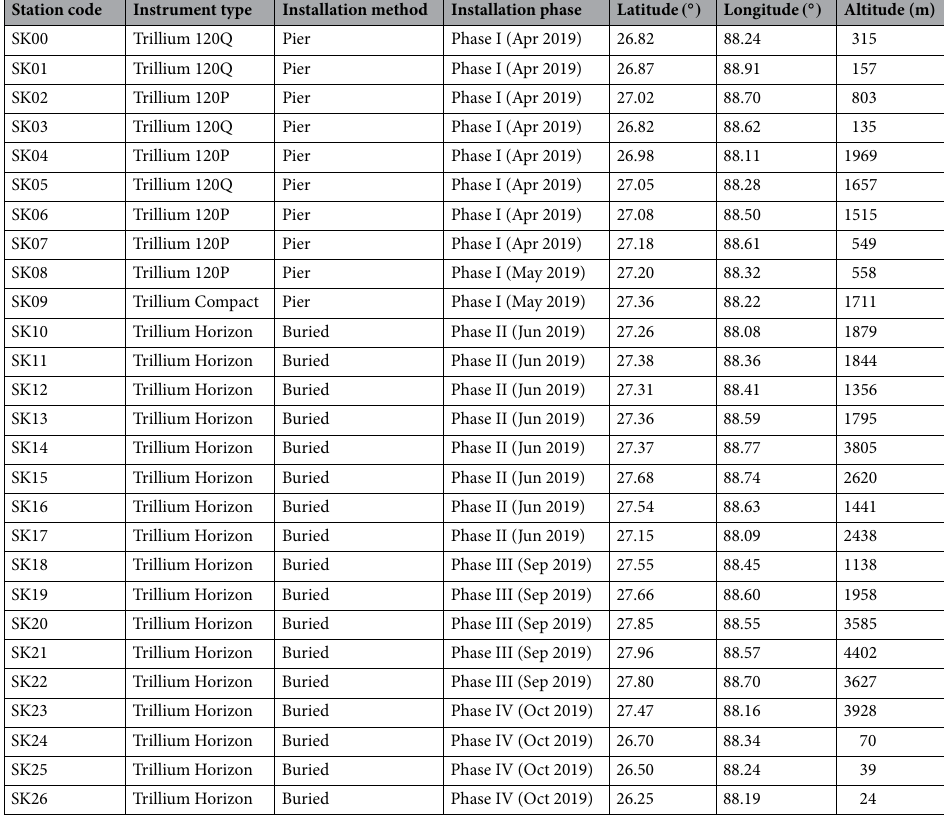
Table 1. List of seismic stations installed, with details of the sensor type and method of installation. Each station records data at 50 samples per